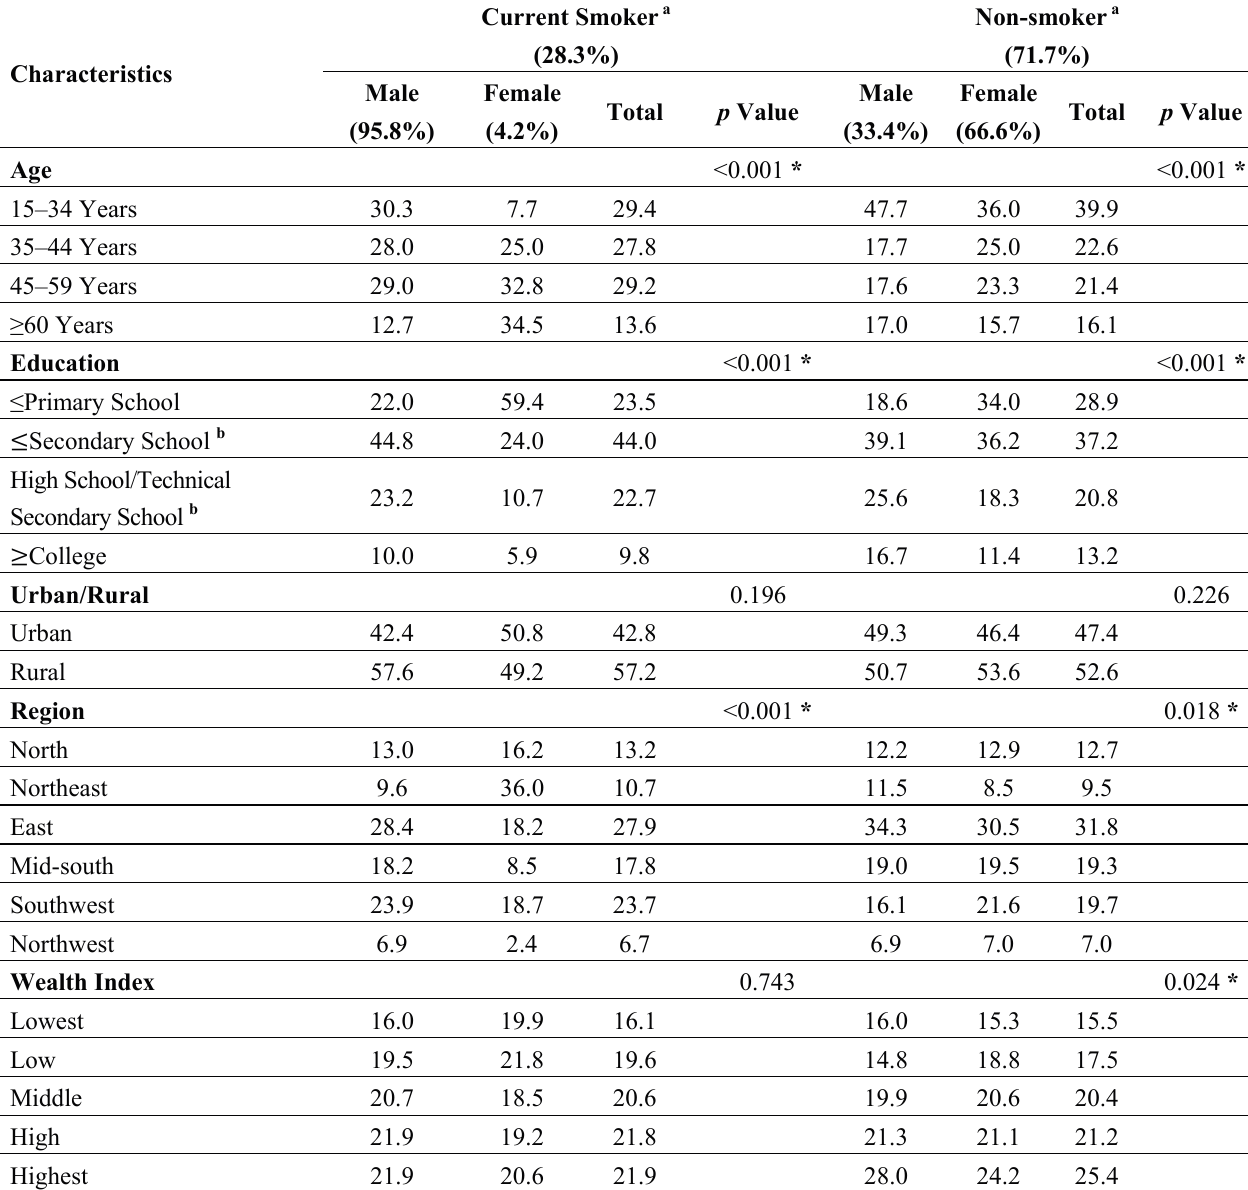
Table 1. Characteristics of study population by smoking status and